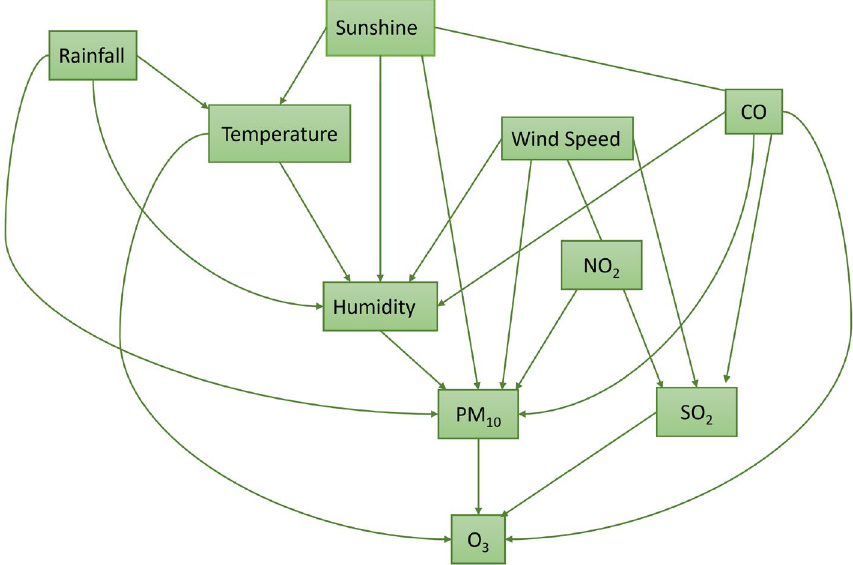
Figure 2. A causal graph is generated from AQI and meteorological conditions.